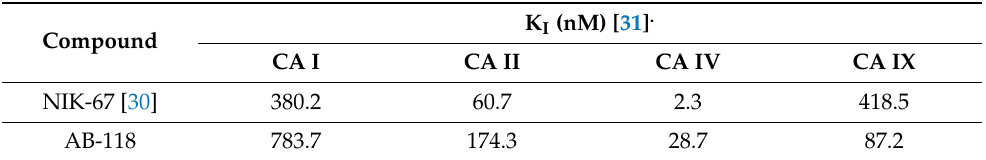
Table 1. Inhibition data of human CA isoforms I, II, IV and IX with NIK-67 and AB-118 by a stopped- flow CO 2 hydrase assay. Mean from three different assays by a stopped-flow technique (errors were in the range of ± 5–10% of the reported